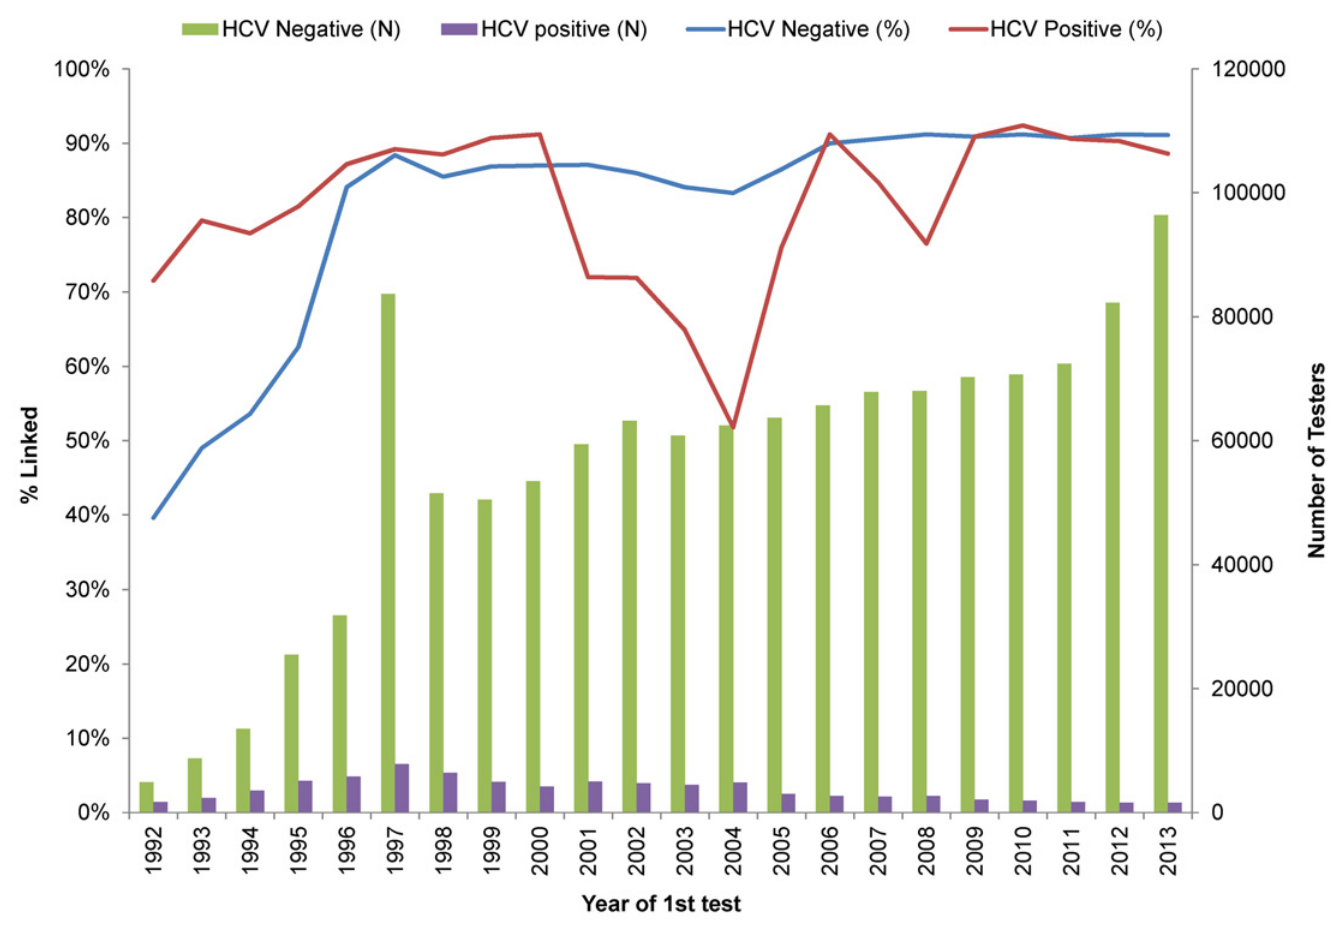
Fig 3. HCV laboratory data linkage rate by year 1992 –